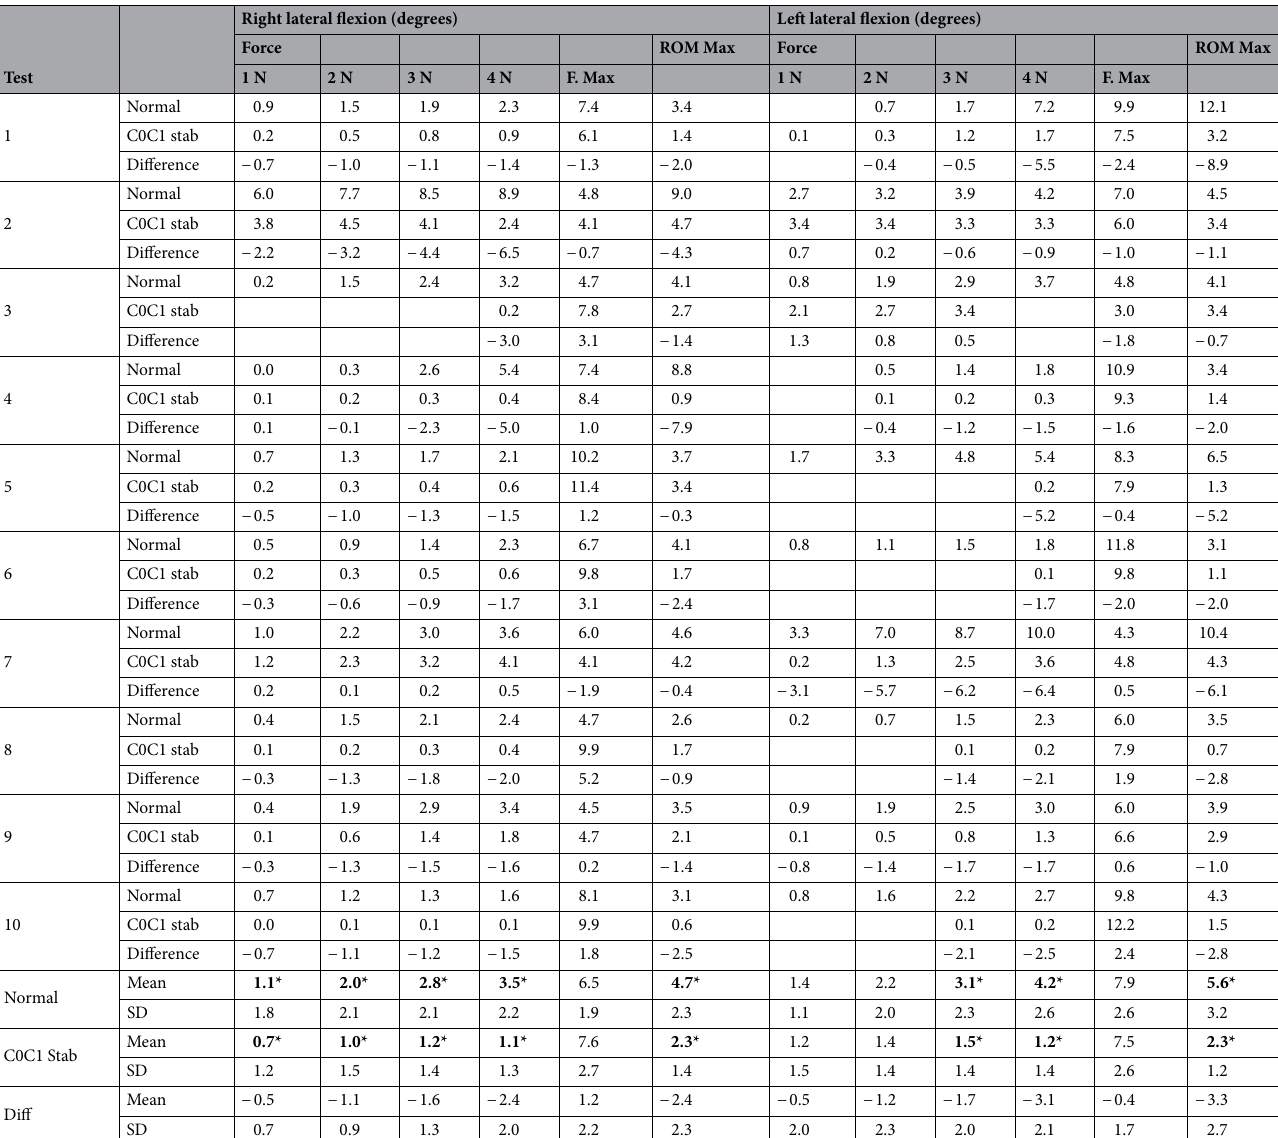
Table 3. Lateral flexion in degrees for the force values of 1, 2, 3, and 4 N during the motion, and the maximum force (F. Max) with its range of motion (ROM Max). The table shows the values for all the specimens before (normal) and after (C0C1 stab) the stabilization of C0–C1. The means and standard deviations for each analyzed force and ROM Max are presented at the last rows of the table. N, Newtons; F max, applied force at end range of motion; ROM max, end range of motion; SD, standard deviation. *Statistical significance p < 0.05 values indicated in